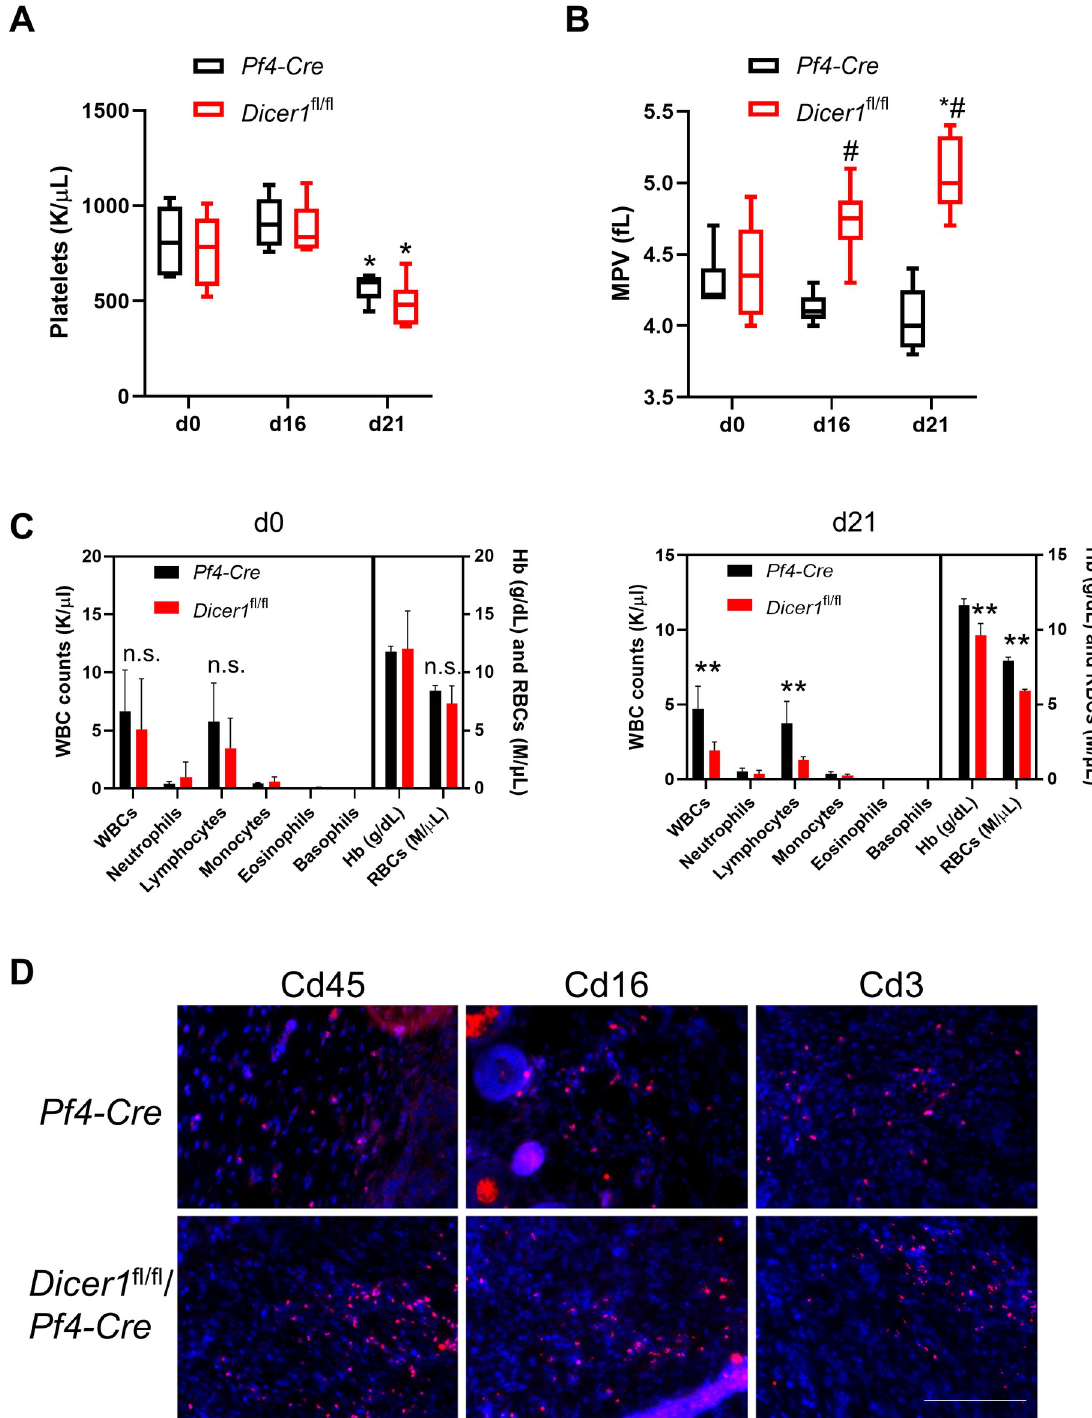
Fig 6. Peripheral blood cell counts, mean platelet volumes, and leukocyte/lymphocyte tumor infiltration in Pf4-Cre and Dicer1 fl/fl / Pf4-Cre mice pre- and post-tumor implantation. Blood was sampled from mice by retroorbital bleeding at the indicated times pre- and post-implantation of KPC tumor cells. Peripheral blood ( A ) platelet counts, ( B ) mean platelet volumes (MPV), ( C ) leukocytes, erythrocytes and hemoglobin (Hb) were assessed by HEMAVET analysis of whole blood, and are shown ± s.e.m. Platelet box plots ( A ) show minimum, maximum, and mean counts. WBCs, white blood cells; RBCs, red blood cells. n = 6. � , p < 0.03 compared to the same genotype at d0; #, p < 0.001 compared to controls on the indicated days; �� , p < 0.04 between genotypes; n.s., not significant. D